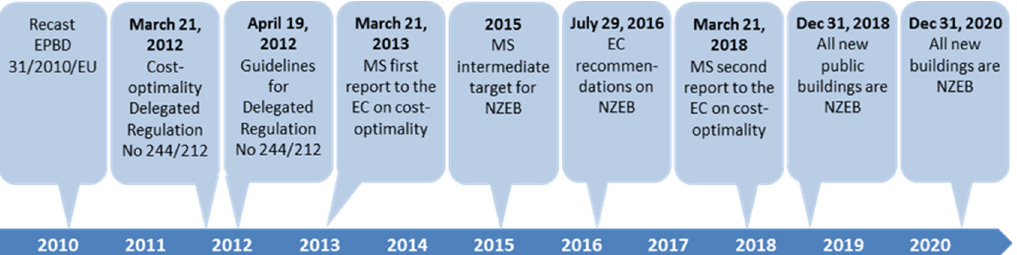
Figure 2. Timeline for cost-optimal and NZEB requirements.